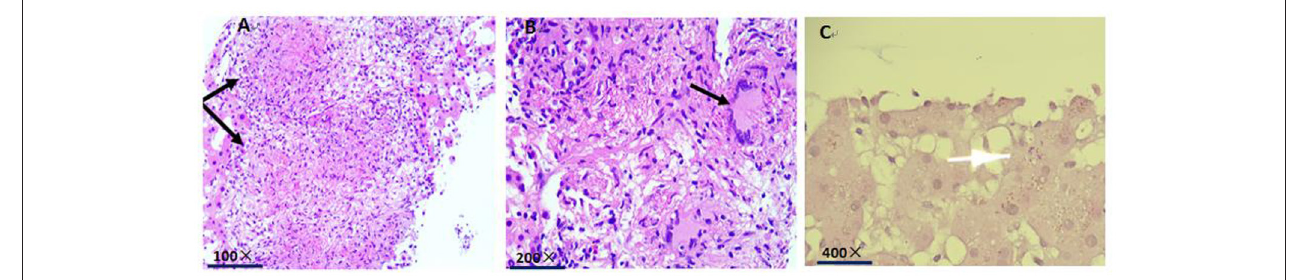
FIGURE 5 | (A) Histopathological examination indicates fusion granulomas with caseous necrosis in the liver tissue (black arrow). (B) histopathological examination indicates Langhans giant cells in the liver tissue (black arrow). (C) acid-fast staining shows mycobacterial accumulation in the cytoplasm (white